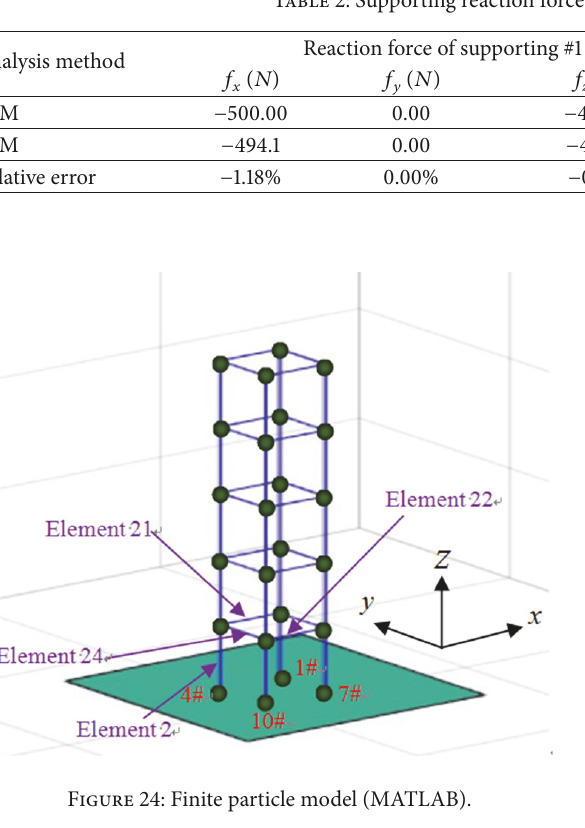
Figure 25: Vertical displacement of various heights under